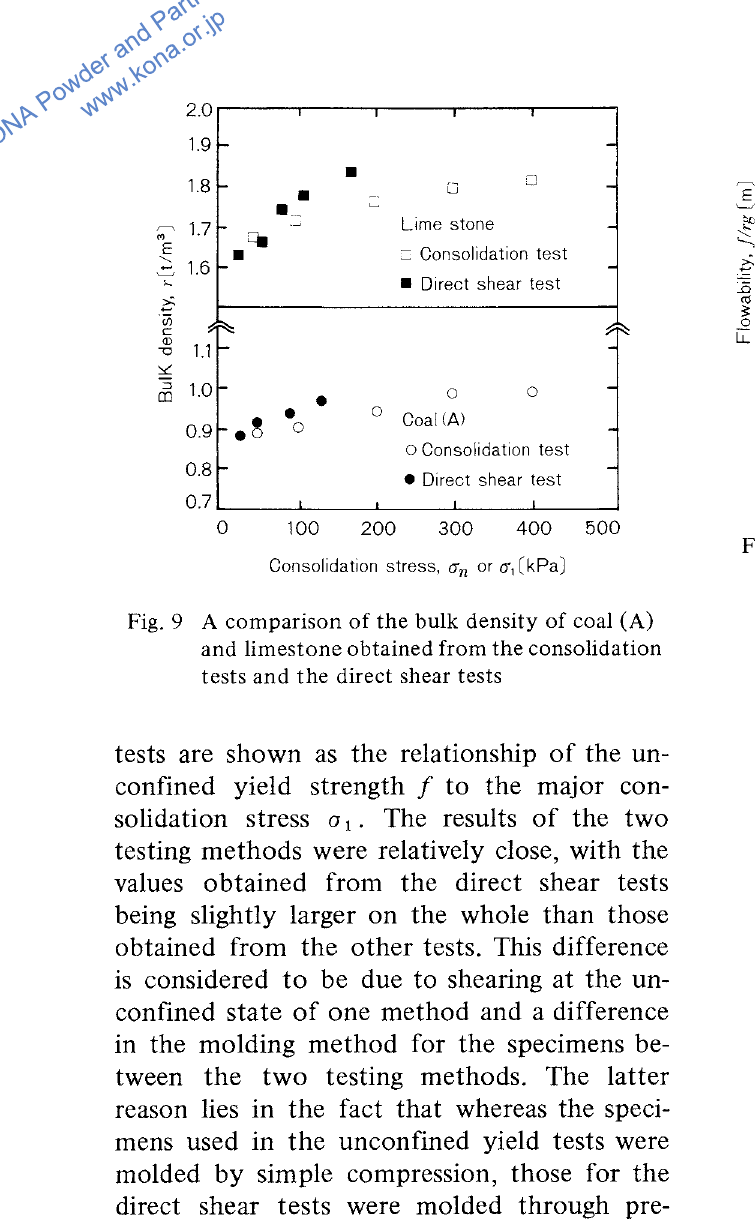
Fig. 11 A comparison of the flowability of wet coals and limestone obtained from both the unconfined yield tests and the direct shear tests the cohesive force and frictional force between particles, signifies a degradation in the flowing property. The respective flow ability indices obtained from both the unconfined yield and direct shear tests are shown in Figs. 10 and 11 for comparison. Although they show some scatter, the results of calcium carbonate, are almost in agreement for both testing